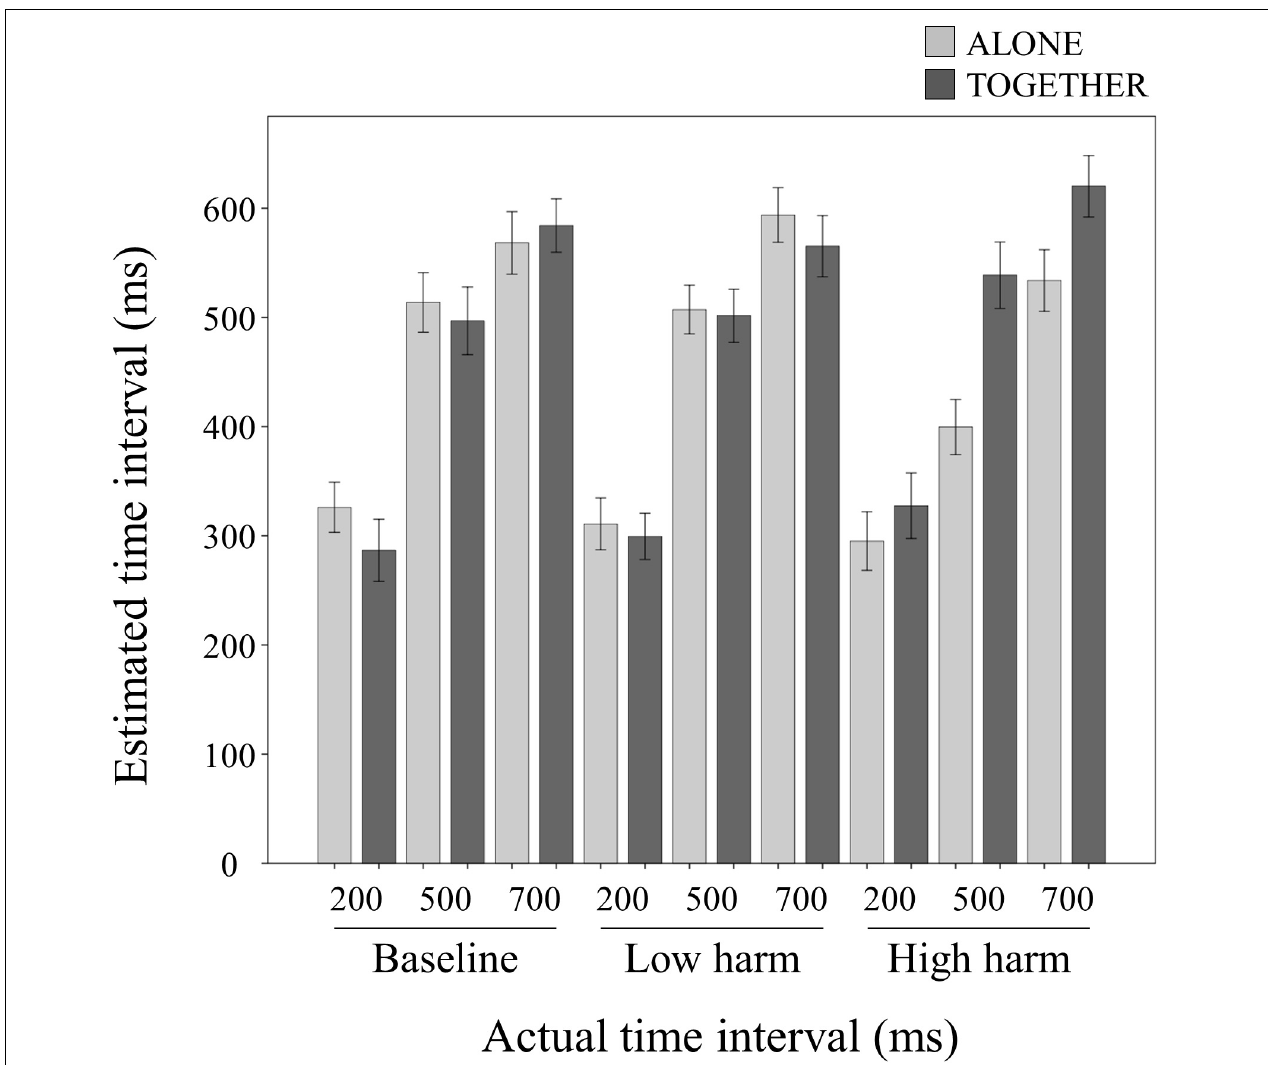
FIGURE 2 | The estimated time interval in each actual time interval. Estimated action-tone intervals (ms) in the ALONE and TOGETHER conditions and negative outcome conditions. Data represent means ± standard